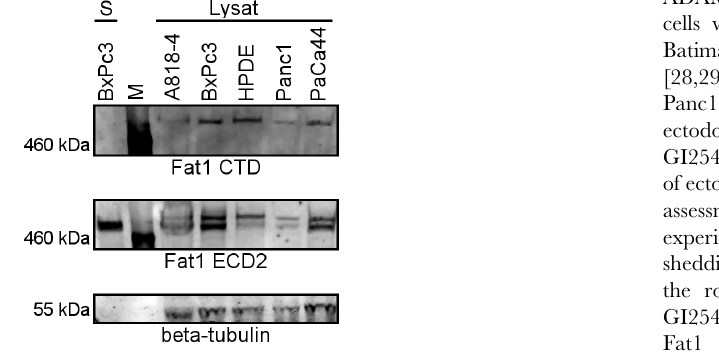
Figure 3. Western blotting indicates the two known forms of Fat1 and a new released form. Cell lysates (75 m g each) and a representative secretome (8 m g) were blotted together with a protein marker (M). The same blot was probed first, with an antiserum raised against the cytoplasmic domain (CTD) of Fat1 and subsequently with an antiserum raised against the extracellular domain (ECD 2). Beta-Tubulin, finally, was used as a loading control for cell lysate. The extracellular domain specific antibodies, only, detect the processed cellular form and the released Fat1 in the secretome.